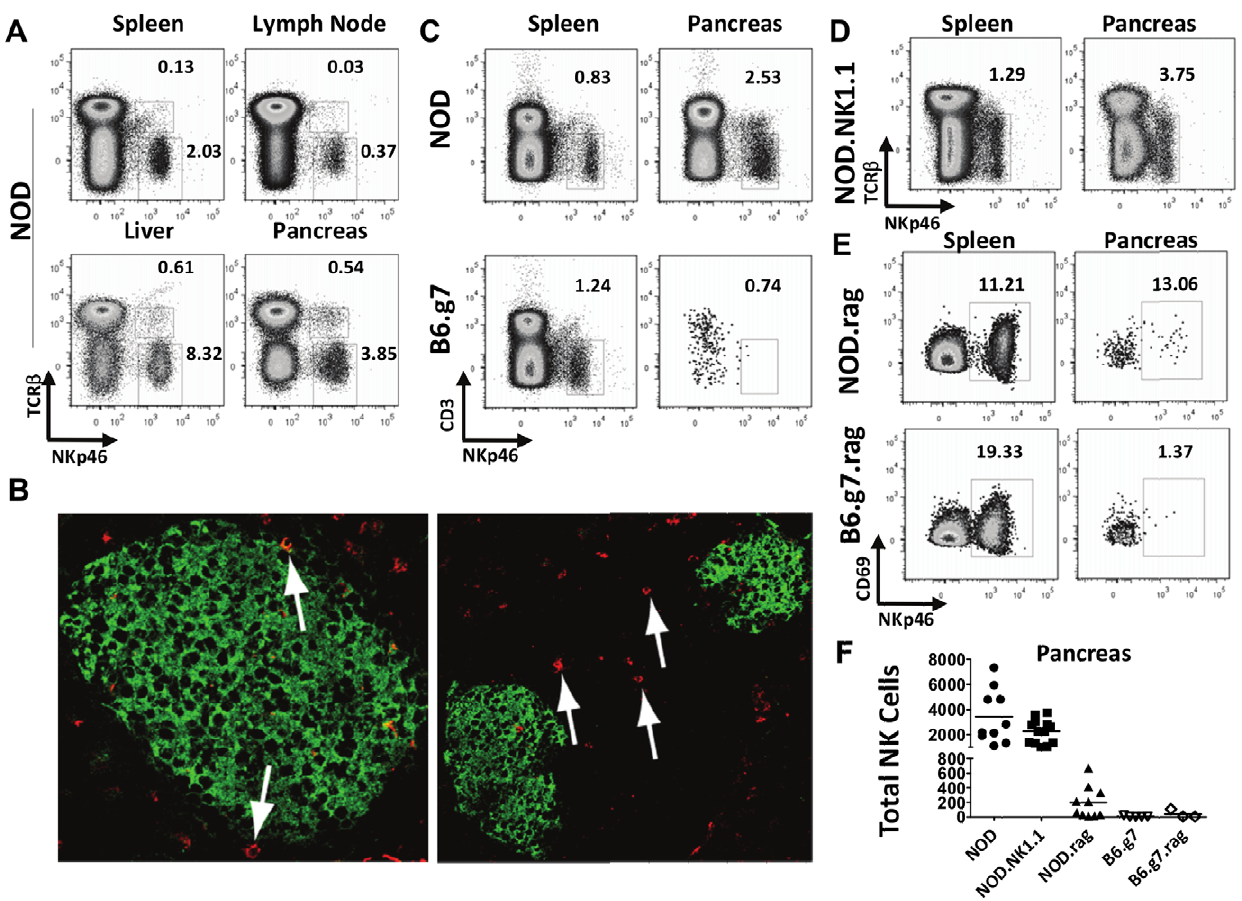
Figure 1. NK cells reside in the pancreas. A) Flow cytometric analysis of leukocytes isolated from enzyme-digested tissues of NOD mice. Plots are of CD45 + cells and numbers are percentages of CD45 + cells. Example of one of six similar experiments. B) Using immunohistochemistry, NK cells (red) were found in the surrounding peri-islet infiltrates (left panel 40 6 ) and in infiltrated islets (right panel 20 6 ). Insulin was stained green to define islets. Example of sections of pancreas from three different NOD mice, evaluating a minimum of 10 slides per mouse. C) NK cells were more numerous in NOD pancreas compared to B6.g7 pancreas– dots were enlarged to allow visualization of NK cells due to low number of events obtained from B6.g7 mice. D) NOD.NK1.1 pancreata contain similar frequencies of NK cells as NOD mice. E) Rag2 2 / 2 NOD mice have low numbers of NK cells in their pancreas, whereas Rag1 2 / 2 B6.g7 mice have very few, almost undetectable numbers of NK cells in the pancreas. F) Absolute numbers of NK cells recovered from the pancreas of individual mice from noted strains. Example from one of six similar experiments, each with a minimum of three mice per strain is shown.